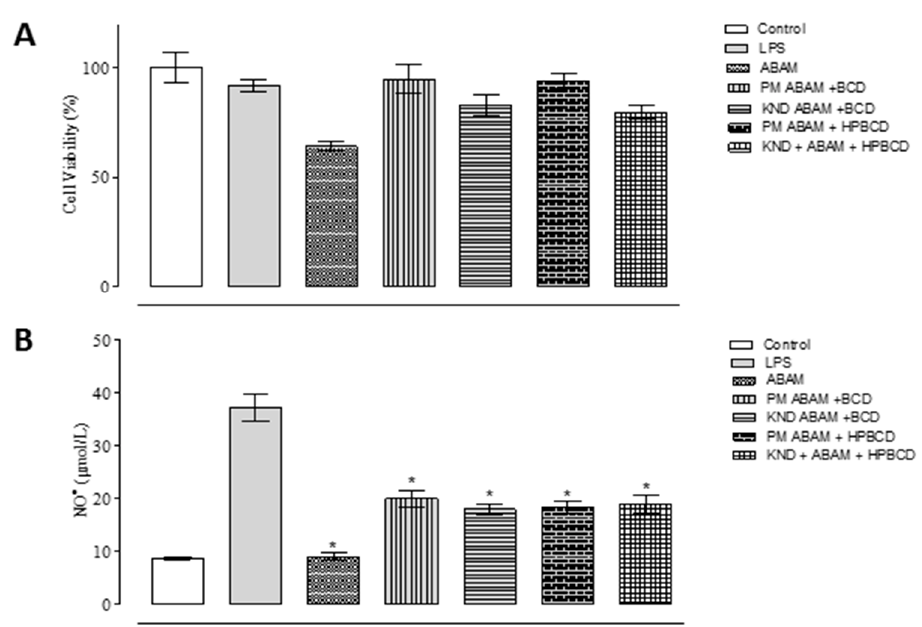
Figure 6. In vitro anti-inflammatory activity in lipopolysaccharide-stimulated mouse macrophage cell line (LPS)-stimulated J774 macrophages for quantification of NO- and cell viability by MTT in cells treated with ABAM and its inclusion complexes with β CD and HP β CD at a concentration of 20 µ g / mL after 24 h. ( A ): Percentage of cell viability after 24 h of treatment with ABAM and its ICs; ( B ): Inhibitory percentage of each individual compounds and the respective ICs towards the production of nitric oxide.